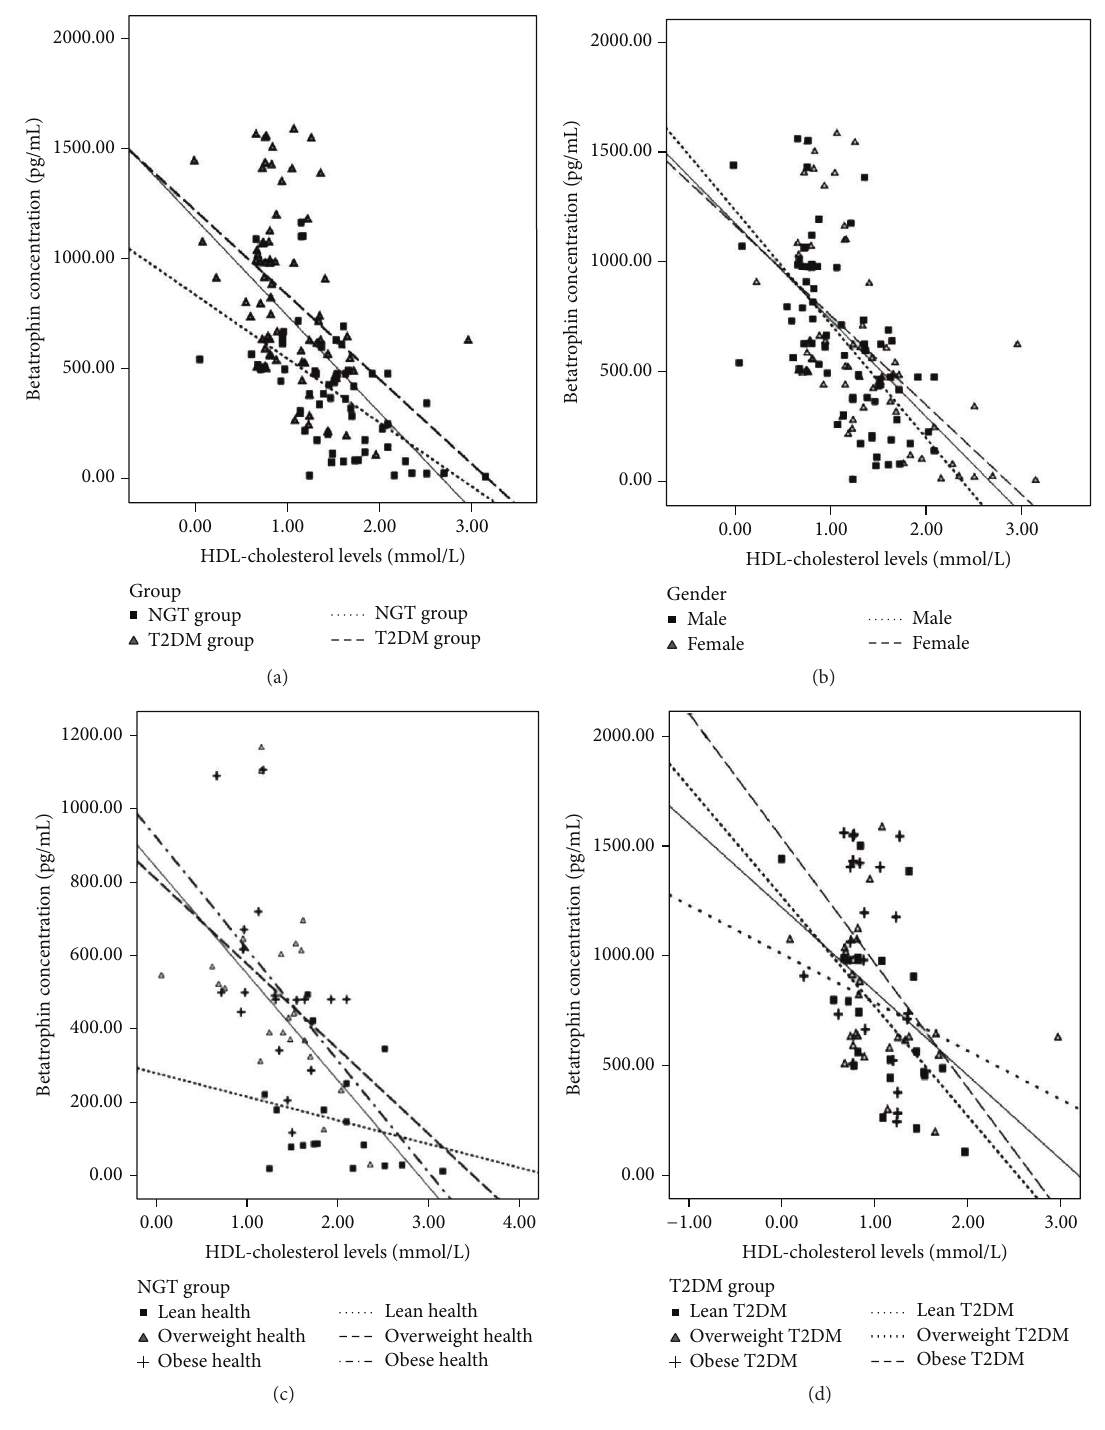
Figure 2: Correlations of serum betatrophin levels with HDL-cholesterol levels in each subgroup. (a) Correlations of serum betatrophin levels with HDL-cholesterol in NDM and T2DM groups. (b) Correlations of serum betatrophin levels with HDL-cholesterol in males and females. (c) Correlations of serum betatrophin levels with HDL-cholesterol in NDM group when stratified by BMI. (d) Correlations of serum betatrophin levels with HDL-cholesterol in T2DM group when stratified by